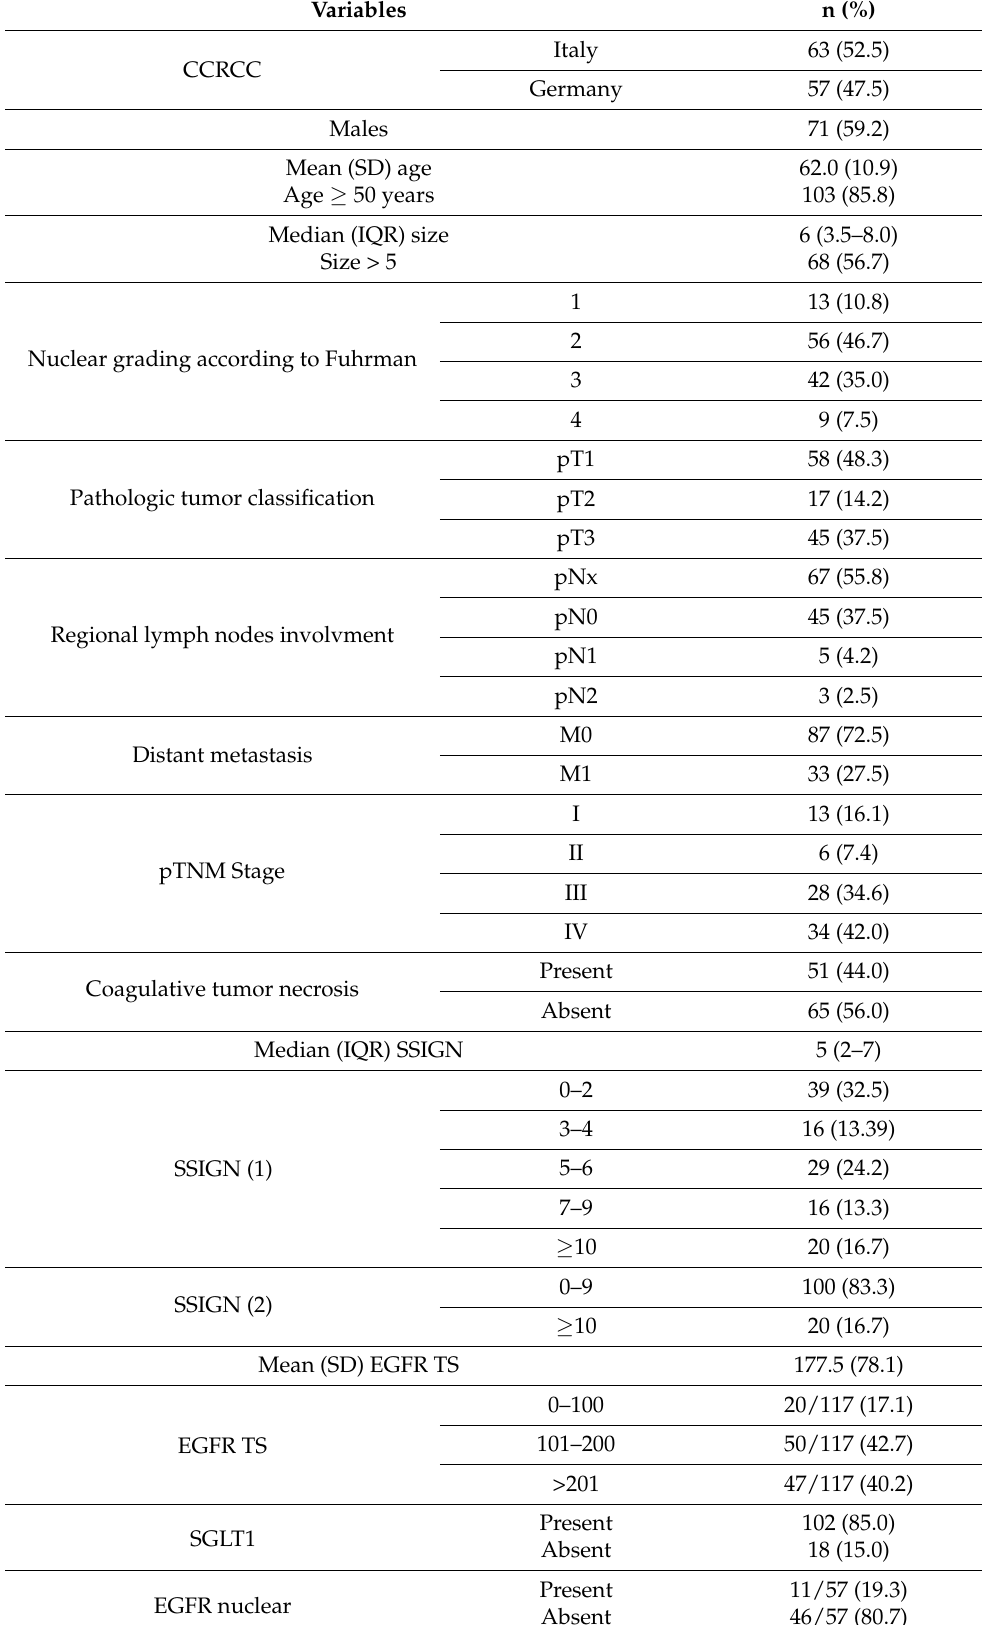
Table 1. Clinico-pathological features of 120 patients with clear cell renal cell carcinoma